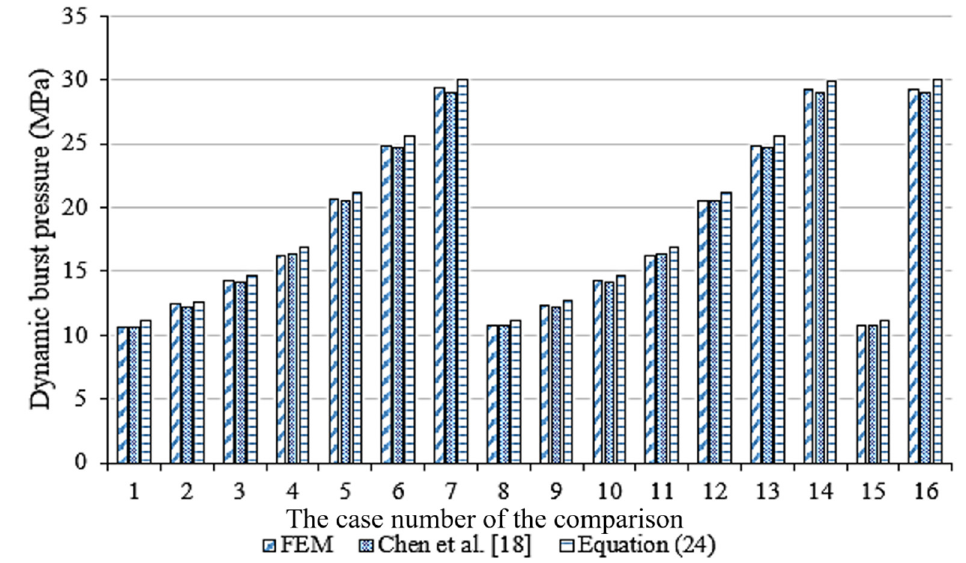
Figure 11. Comparisons between the FEM results and Equation (24), when t d = 390 ms.